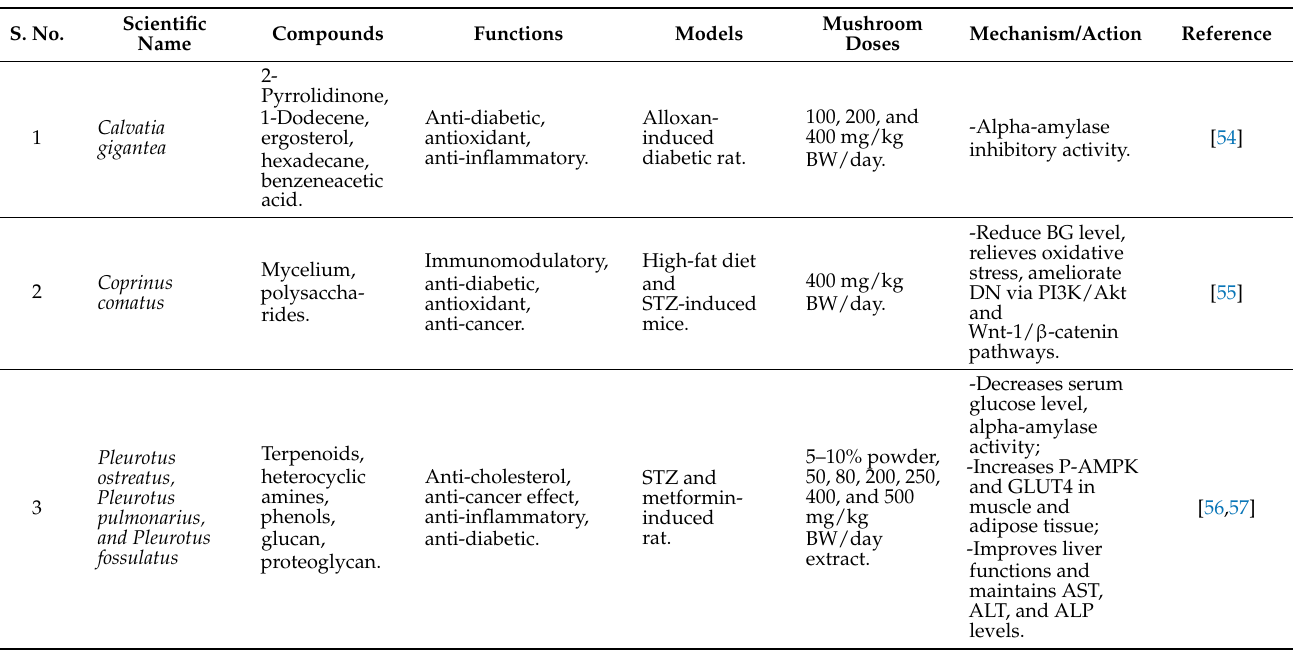
Table 2. Bioactive compounds of edible mushrooms and their effect on in vivo and in vitro study